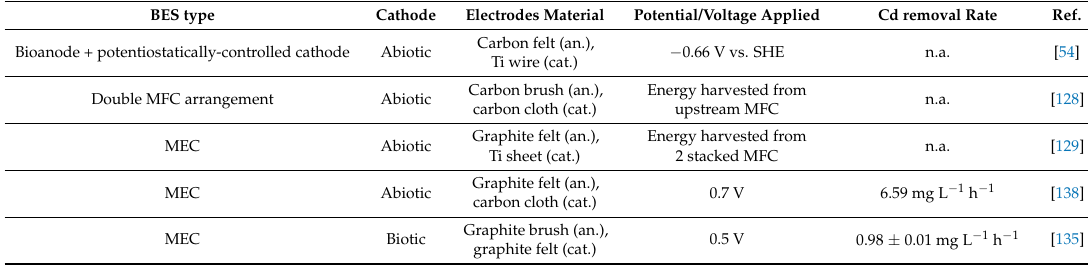
Table 4. Cadmium removal using BES.